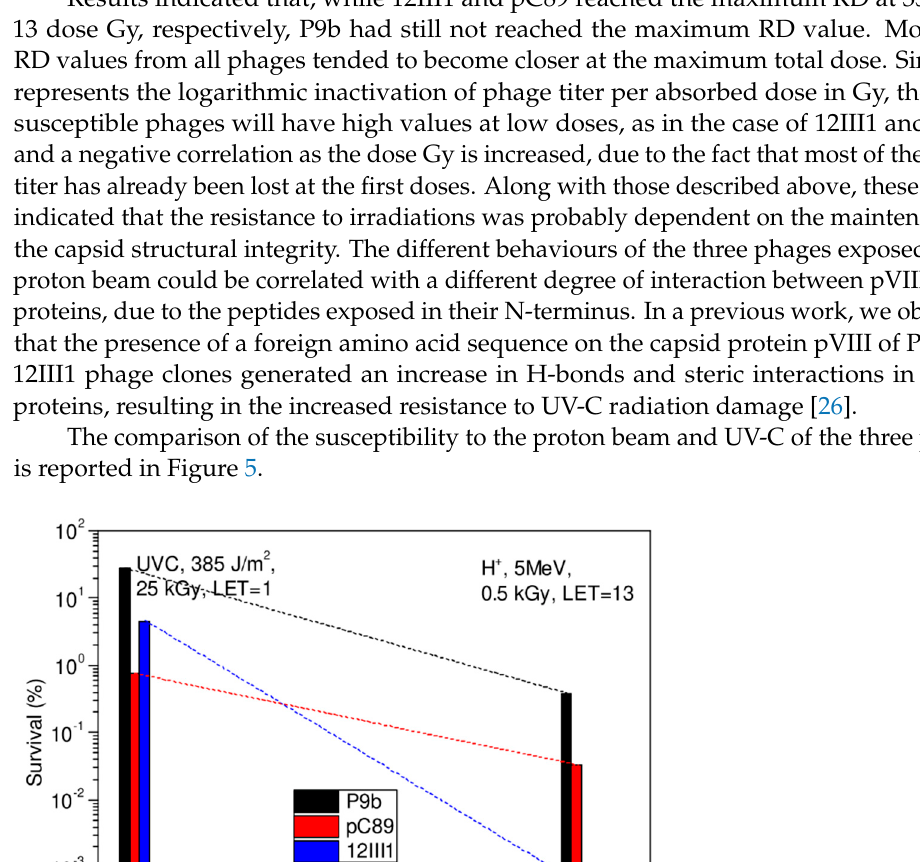
Figure 4. Radiation damage (RD) for each phage as a function of absorbed proton dose and the dose rate.